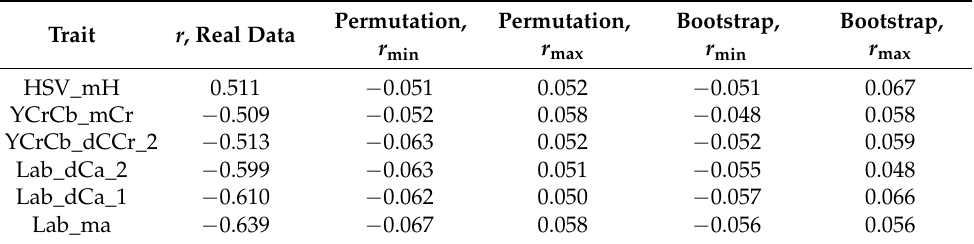
Table 1. Traits of grain color with the most pronounced correlation with the harvesting year (YearRank coding) and estimates of the Pearson correlation coefficients for them in the real sample ( r ) and their minimum ( r min ) and maximum ( r max ) values for the permutation and bootstrap tests. Permutation, Permutation, Bootstrap, Bootstrap, Trait r , Real Data r min r max r min r max HSV_mH 0.511 − 0.051 0.052 − 0.051 0.067 YCrCb_mCr − 0.509 − 0.052 0.058 − 0.048 0.058 YCrCb_dCCr_2 − 0.513 − 0.063 0.052 − 0.052 0.059 Lab_dCa_2 − 0.599 − 0.063 0.051 − 0.055 0.048 Lab_dCa_1 − 0.610 − 0.062 0.050 − 0.057 0.066 Lab_ma − 0.639 − 0.067 0.058 − 0.056